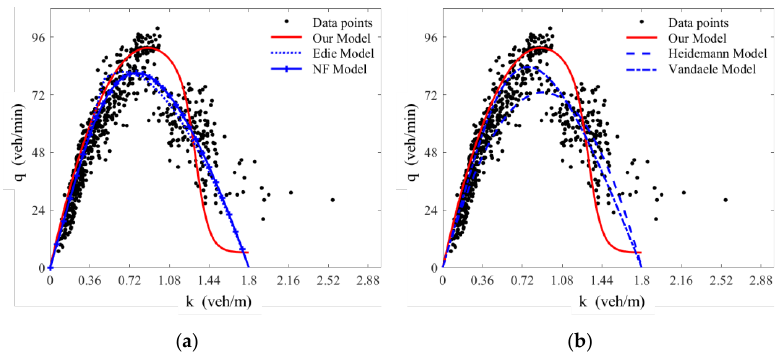
Figure 6. Comparison with other models. ( a ) is comparison with Edie model and NF model; ( b ) is comparison with Heidemann model and Vandaele